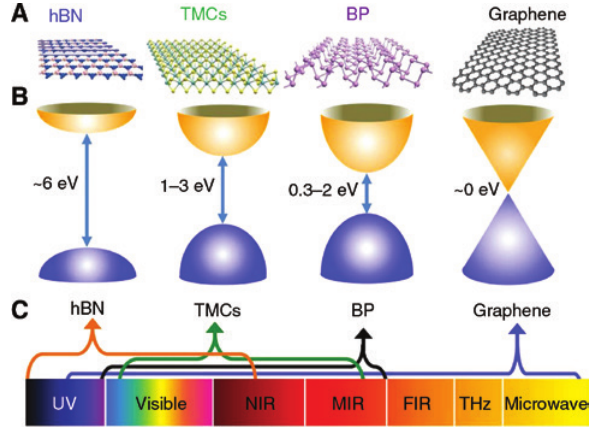
Figure 7: Structure and spectral domain of applications of several 2DLMs. Atomic crystal structures (A), electronic band diagrams (B),